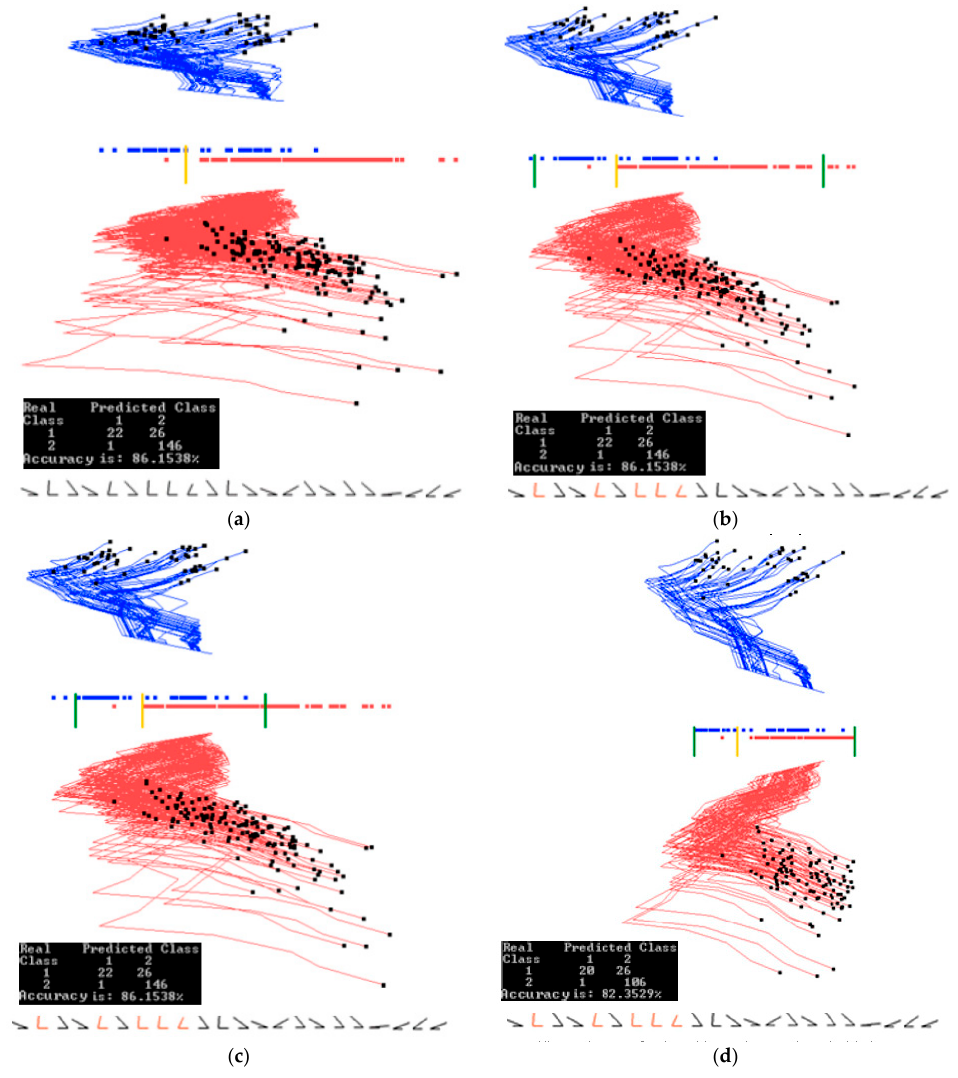
Figure 12. Additional Parkinson’s disease experiments. ( a ) Best projection from the second run of 20 epochs. ( b ) Projection with 5 dimensions removed. Separation line threshold is also moved. Accuracy stays the same; ( c ) Two limits for a subinterval are set; ( d ) Only cases for the subinterval are projected with the separation line moved. Accuracy drops.